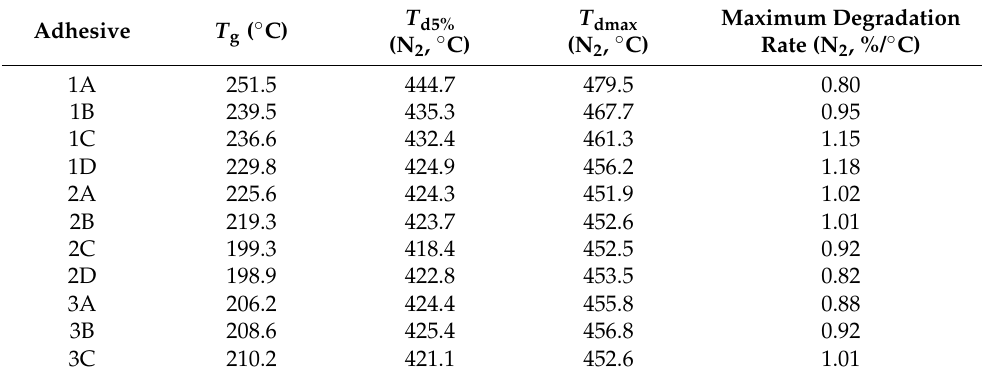
Table 2. Characteristic heat resistance data of the BMI